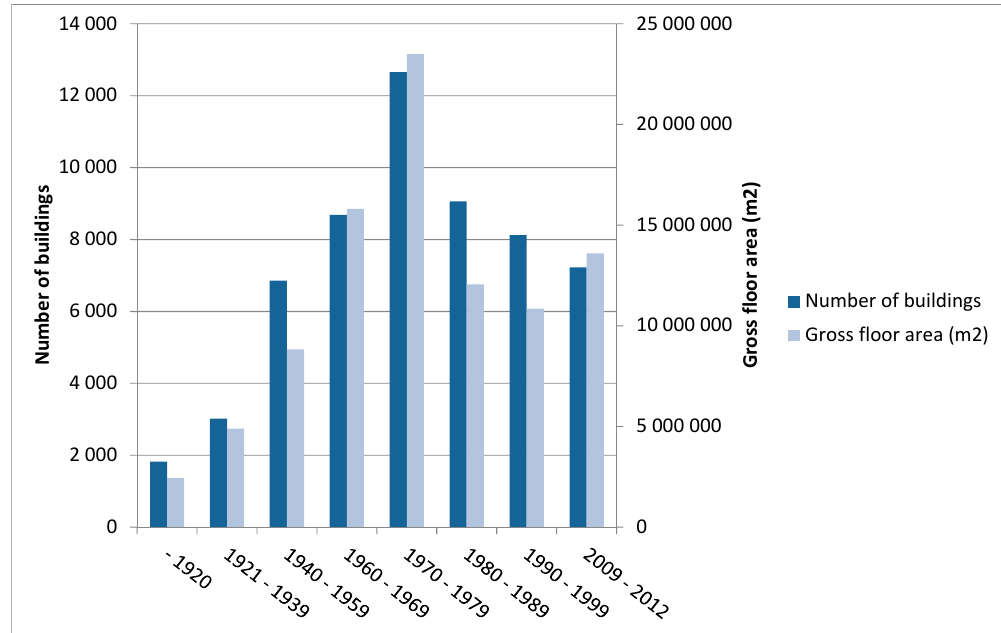
Figure 2. The Finnish apartment building stock as of 31.12.2012 [56]. Table 3. Design and actual average thicknesses of insulation layers in Finnish apartment buildings based on the year of construction [60].